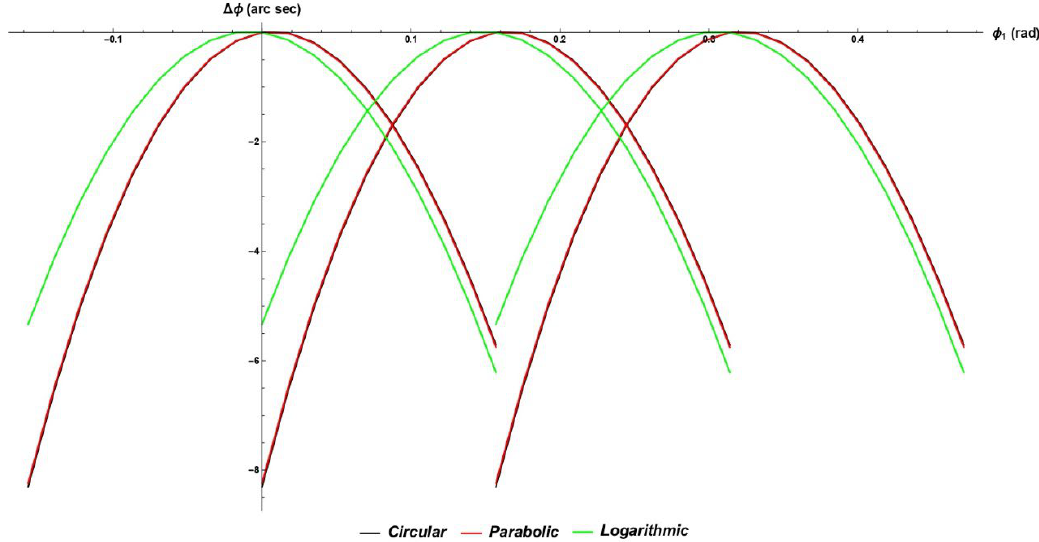
Figure 20. TE of helical gear with three types of modification and 0.2° (3.5 mrad) of out-of-plane angular misalignment.